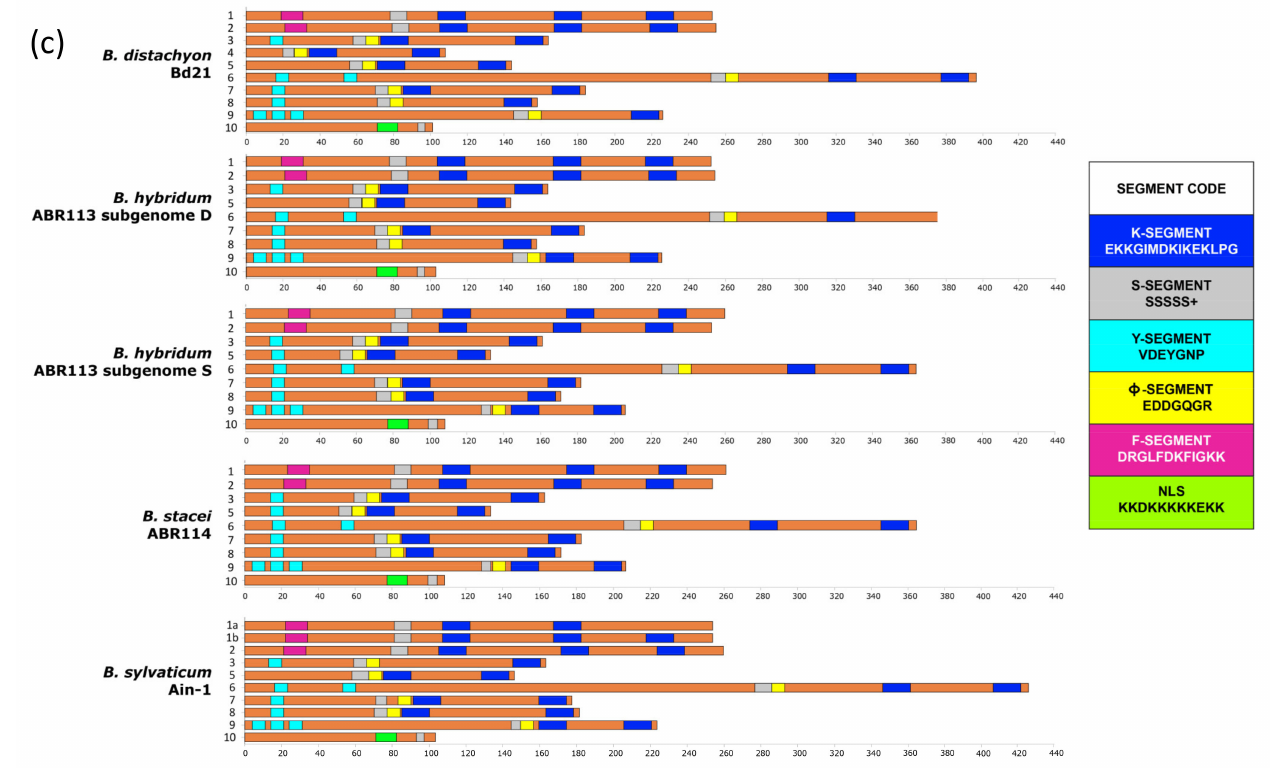
Figure 1. Schematic structure of a typical grass DHN gene showing the positions of the main domains and coding segments ( a ). Gene structure of Brachypodium distachyon Bd21, B. stacei ABR114, B. hybridum ABR113 (D and S subgenomes), and B. sylvaticum Ain-1 dehydrins showing: ( b ) the three detected DNA J (purple rectangle), DNA J-X (light green rectangle) and dehydrin (dark green rectangle) domains, and their CDSs (orange bars), introns (grey lines), and 5 (cid:48) and 3 (cid:48) UTRs (blue bars); ( c ) the conserved motifs of their CDSs with their respective K (dark blue), S (grey), Y (light blue), φ (yellow), F (pink), and NLS (light green) segments. Brachypodium dehydrin gene codes ( Bdhn1–Bdhn10 ) correspond to those indicated in Table 1. Cis -regulatory elements BES1, MYB124, and ZAT are mapped in the promoters of each gene (see color codes in the chart; the figure could be also visualized in http://zeta.uma.es/public/journal/brachy/DHN_Brachy_4_varieties.html, 29 November 2021). Table 1. Dehydrin genes found in the studied Brachypodium distachyon , B. stacei , B. hybridum (subgenomes D and S),